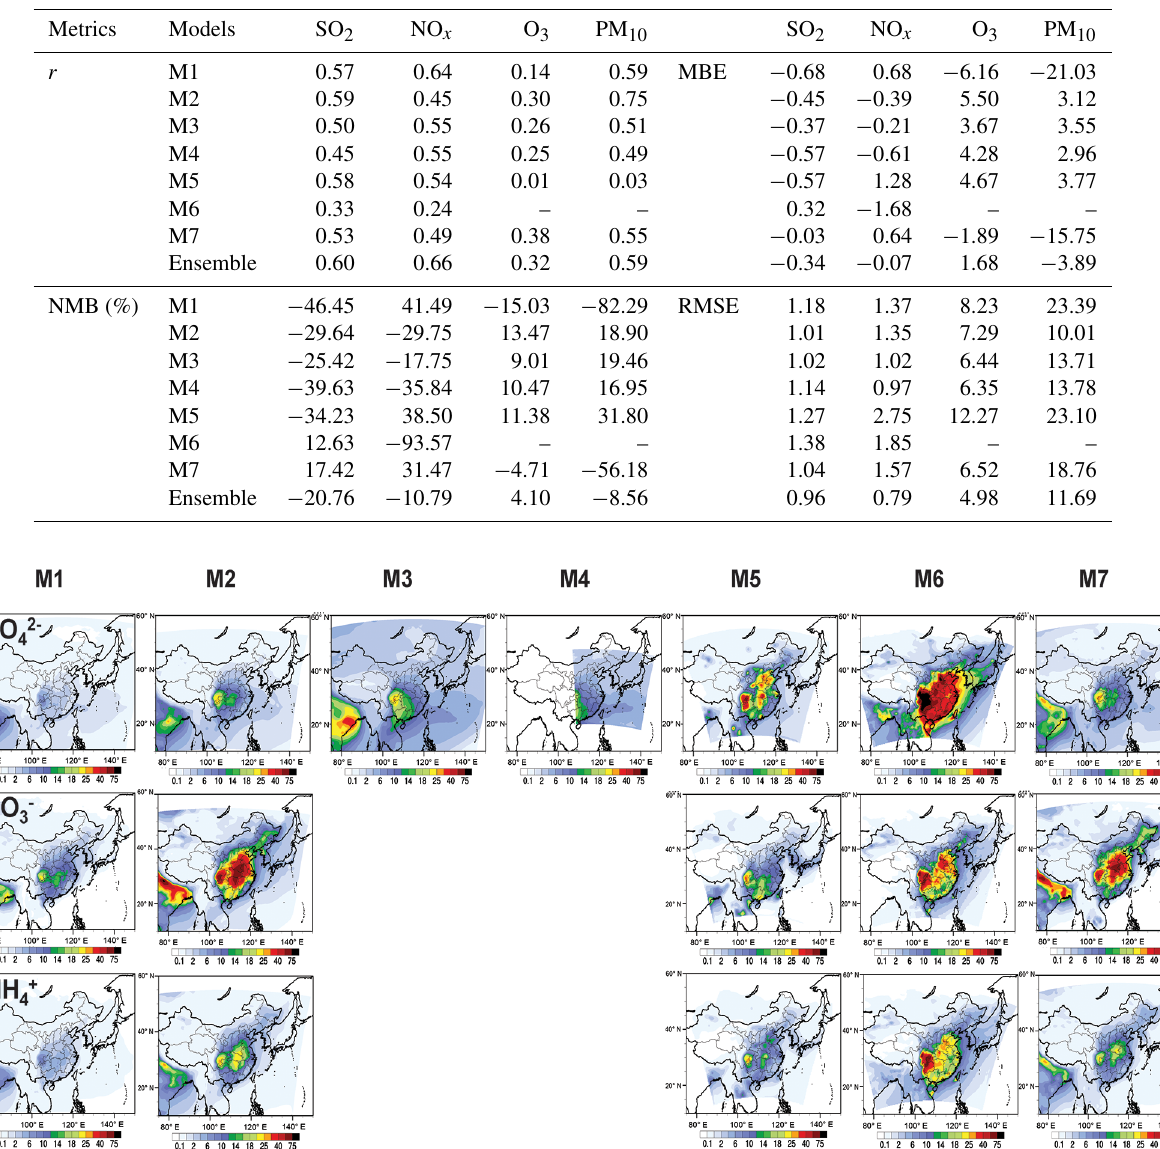
Table 5. Performance statistics of air pollutants at the EANET sites (RMSE and MBE units: ppbv for gases and µgm − 3 for PM). Metrics